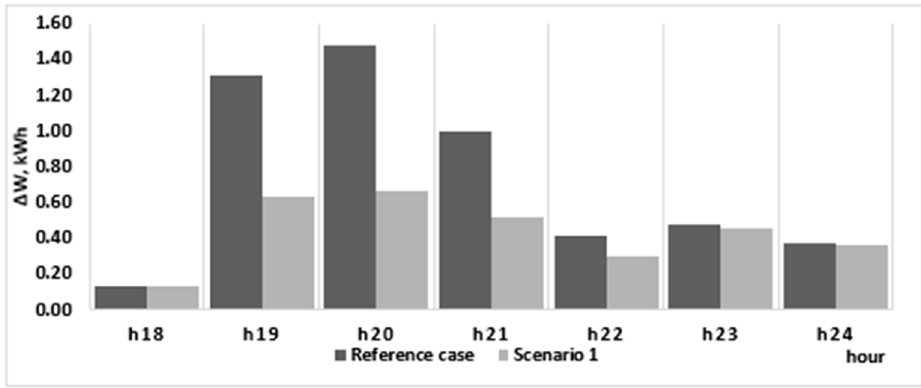
Figure 9. The energy loss reduction at peak hours, Scenario 1.